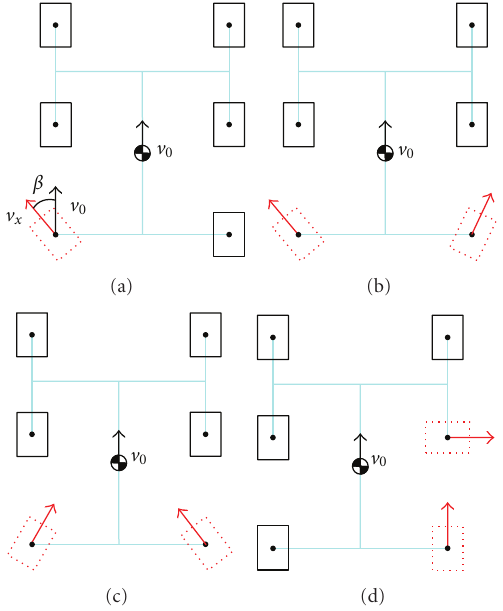
Figure 10: Failed steering motors stuck at di ff erent angles: (a) rear- left wheel; (b) rear-left and rear-right wheels pointing outwards; (c) rear-left and rear-right wheels pointing inwards; (d) rear right and middle right pointing perpendicular to each